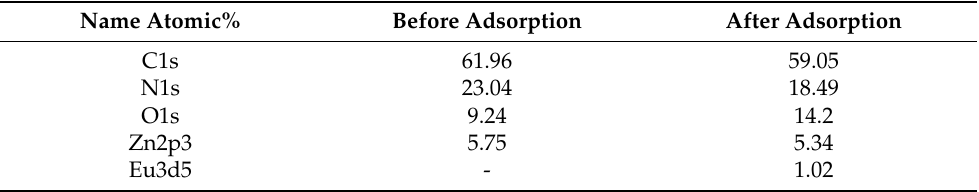
Table 5. Atomic ratio of EDTA–CS@ZIF-8 before and after adsorption of Eu(III) by XPS